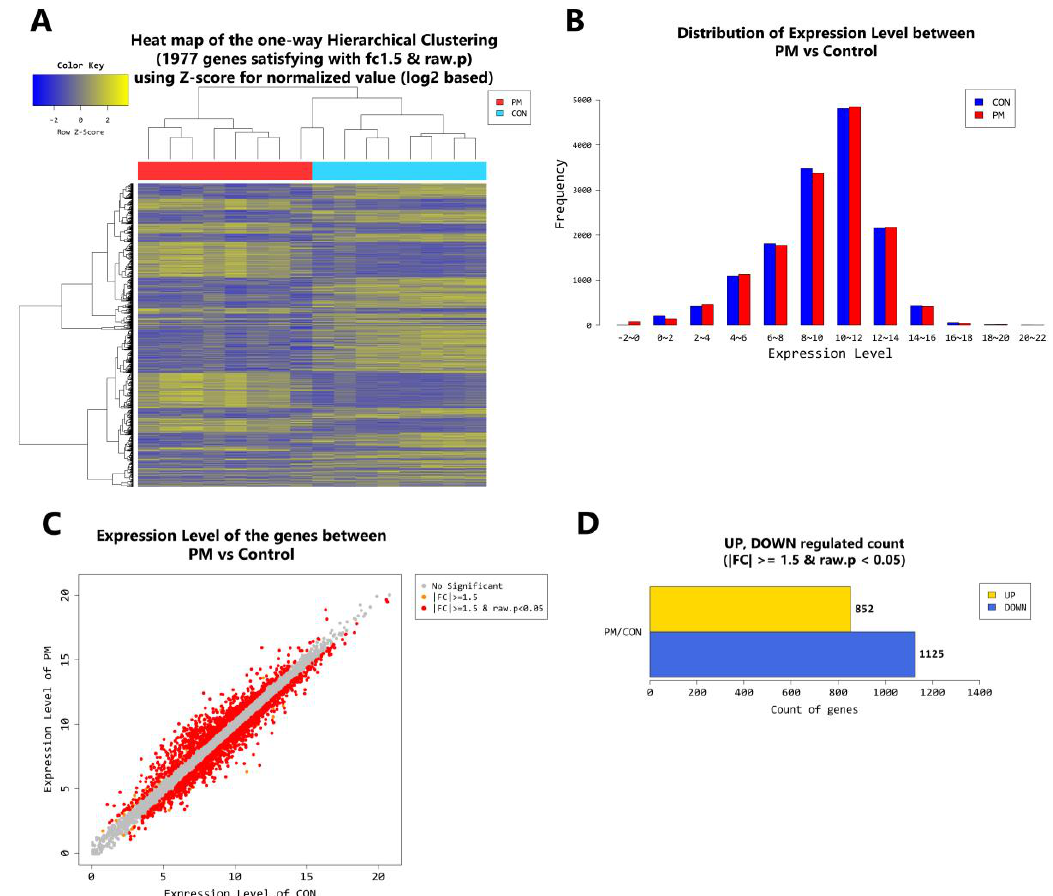
Figure 3. ( A ) Heat map of the one-way hierarchical clustering (PM vs. control). ( B ) Distribution